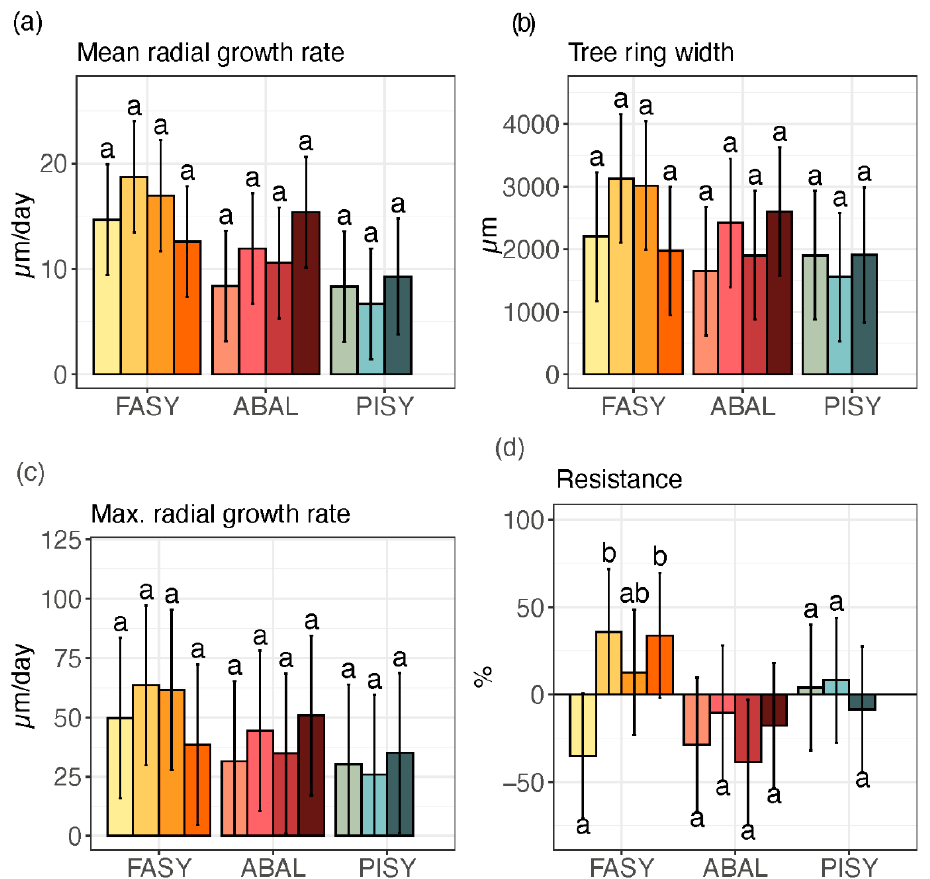
Figure 7. Estimated marginal means of the xylem growth by elevation and tree species (mean radial growth rate) ( a ), maximum radial growth rate ( c ), tree-ring width (b ) and the difference between 5-year mean tree-ring width before 2018 and tree-ring width of 2018 ( d ); FASY: Fagus sylvatica , ABAL: Abies alba , PISY: Pinus sylvestris ). Error bars indicate 95% confidence levels of estimated marginal means. Color legend see Figure 5. Different lowercase letters indicate significant differences of the sample means between the tree species ( p < 0.05).